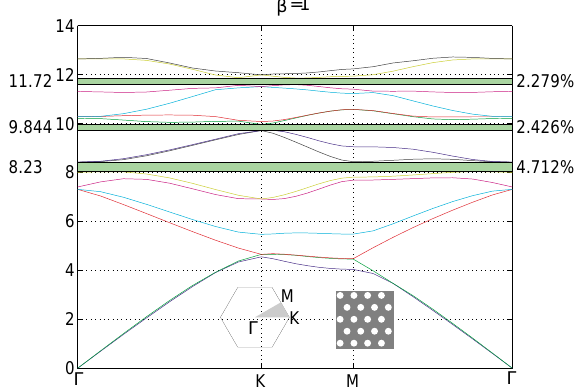
FIG. 3. (Color) Photonic band gaps in 2D. The band diagram is plotted over the irreducible Brillouin zone, highlighted in light gray. A section of the periodic structure is also illustrated, with silica in gray and air in white. The green regions in the plot are the band gaps. Midgap values and gap (cid:3) midgap ratios are displayed on the left and right of the band,